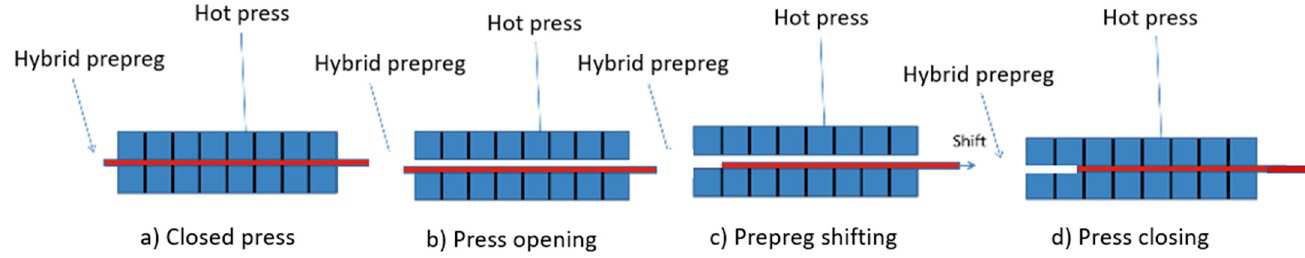
Figure 3. Hybrid Prepreg Motion under the Press.